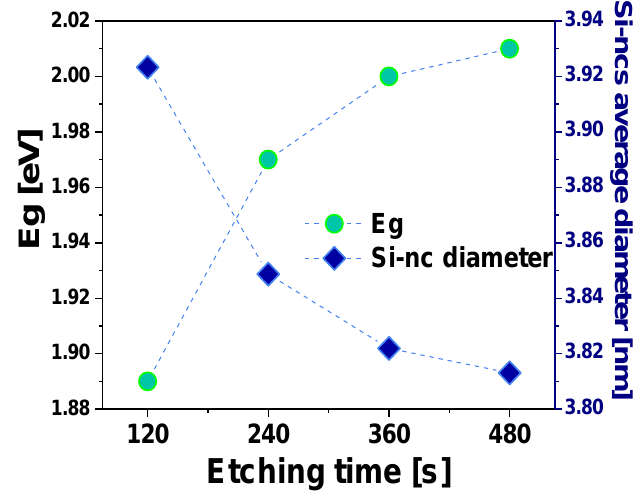
Figure 5. 𝐸 𝑔 and Si-ncs average size of the SiP layers vs. etching time. Figure 5. E g and Si-ncs average size of the SiP layers vs. etching